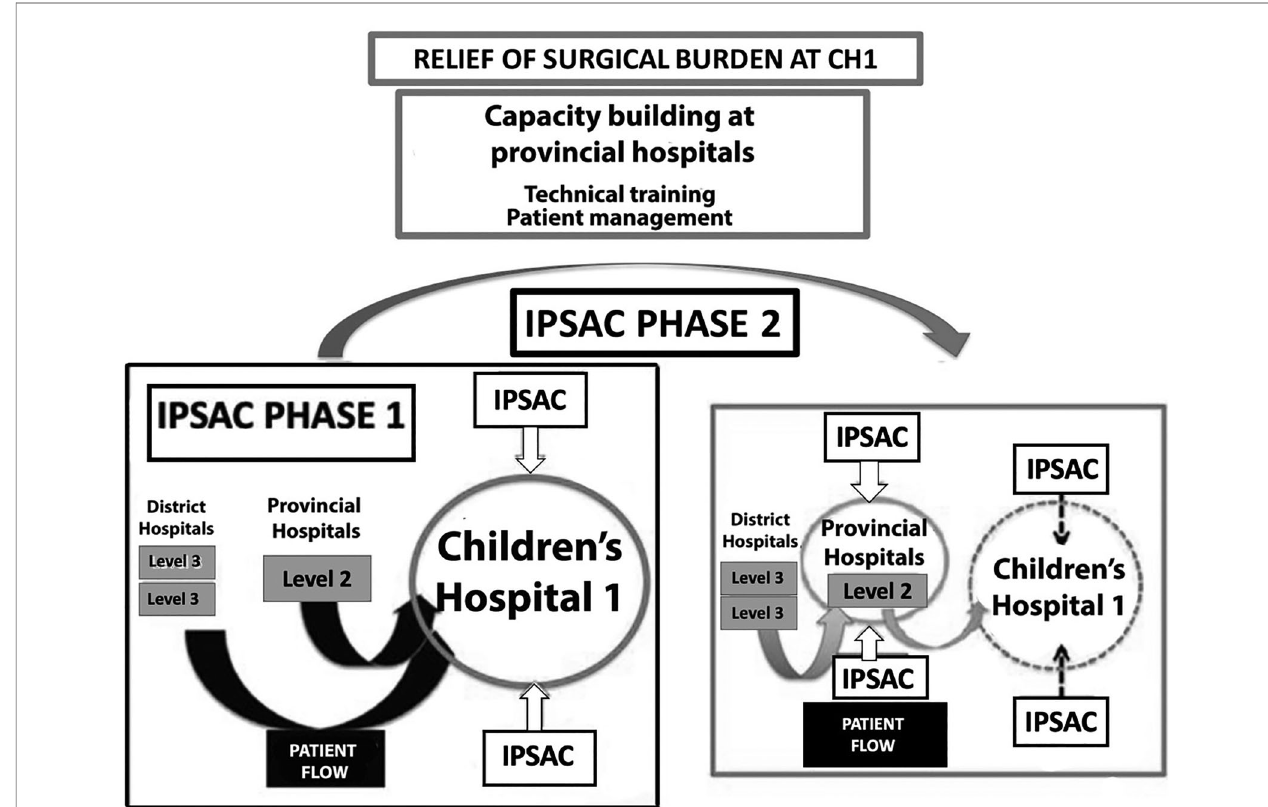
FIGURE 2 | Diagram of Phases 1 and 2 of CH1-IPSAC joint surgical capacity building at the af fi liated hospitals to relieve patients ’ surgical